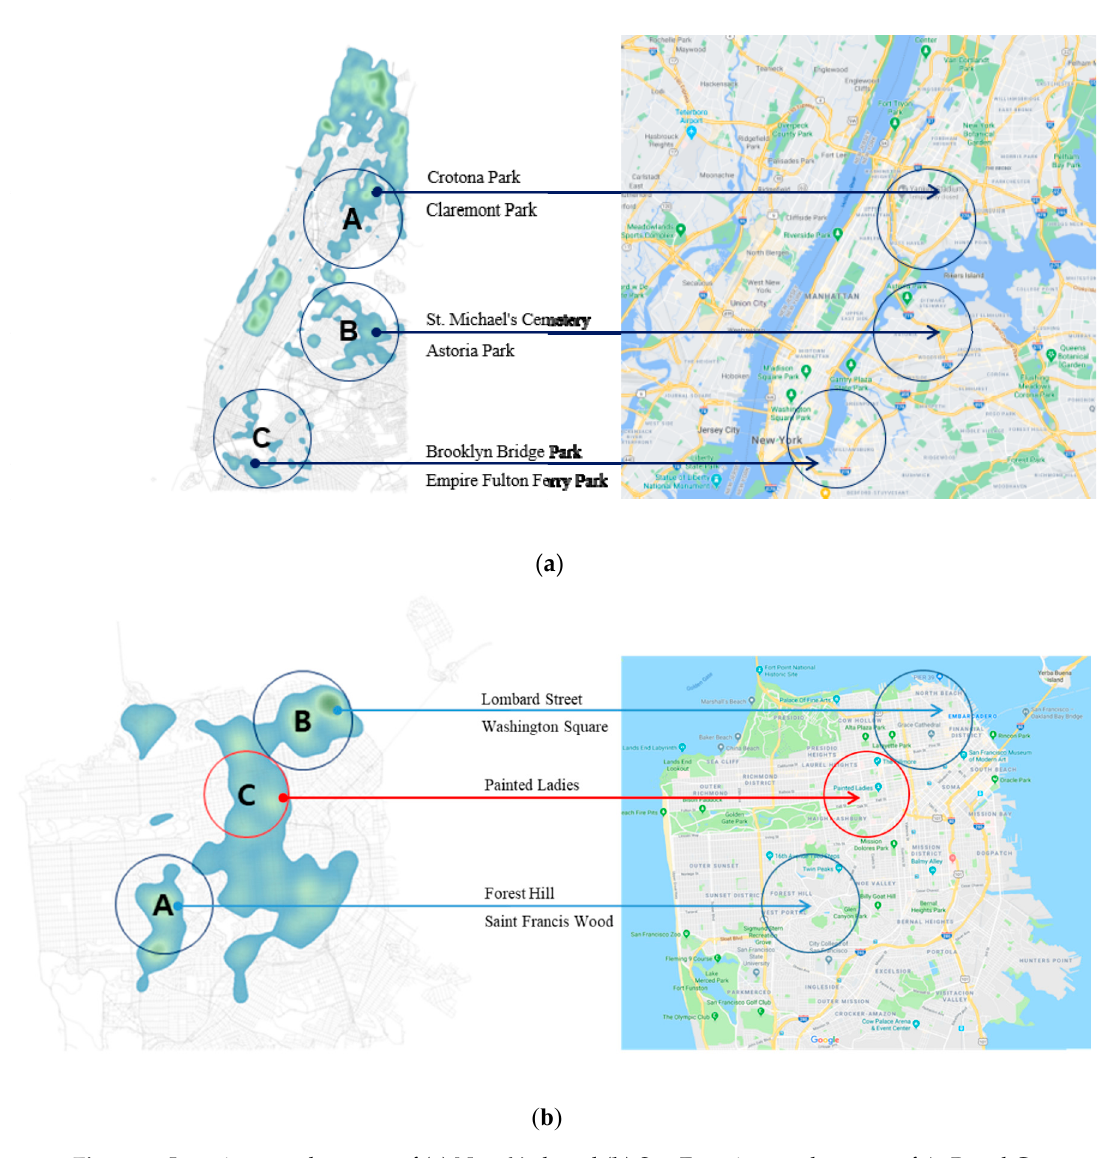
Figure 6. Comparison of significant areas in San Francisco. (a) NDVI analysis result; (b) UGA heat map with choice 1600 m setting; (c) UGA heat map with integration 1600 m setting.